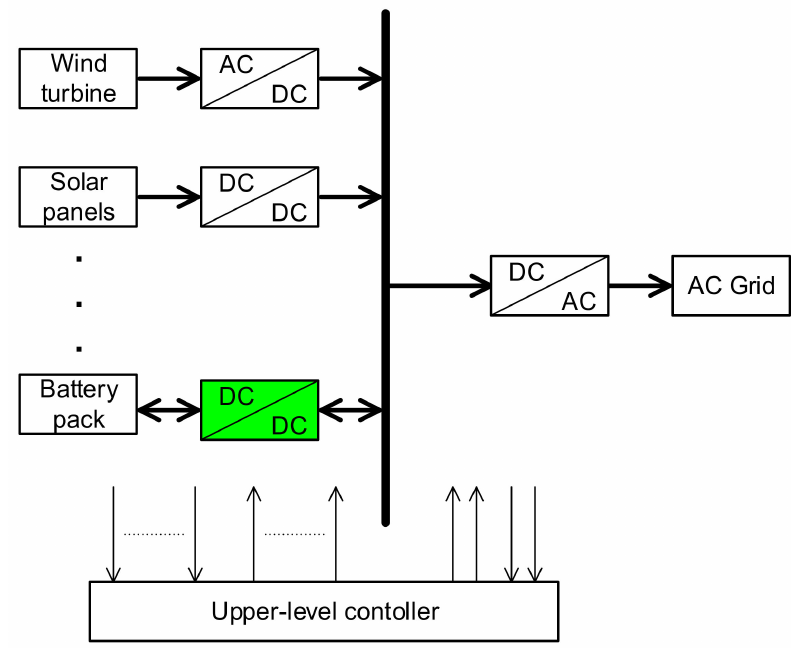
Figure 1. Example of smart household utilizing various energy storage elements and